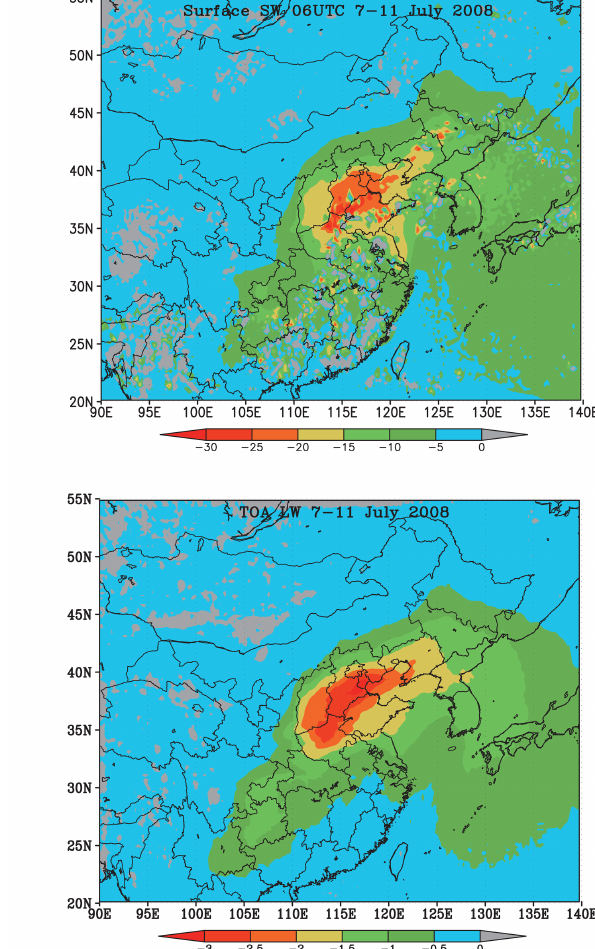
Figure 2. The percentage of change in the surface SW flux at 06:00 UTC (a) and in TOA outgoing LW flux (b) due to aerosol DRF during the 7–11 July